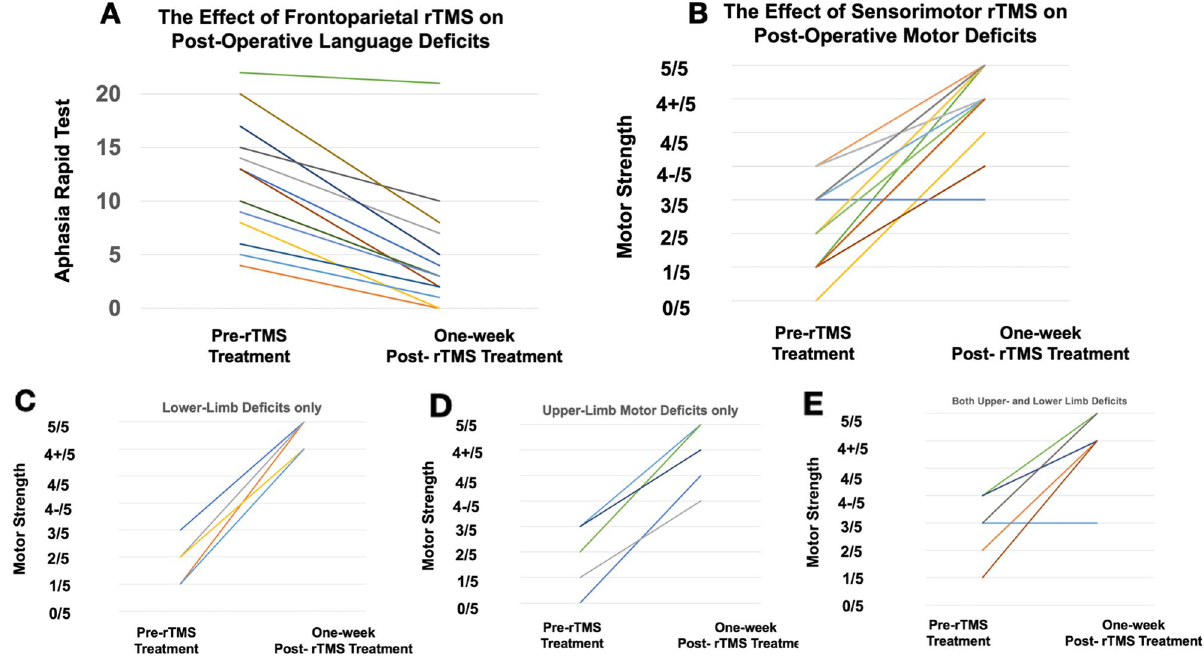
Figure 4. Neurological data (both language and motor) pre-rTMS treatment and 1-week post-rTMS treatment. ( A ) demonstrates a significant decrease in the ART 1-week following frontoparietal rTMS (p = 1.48 × 10 –3 . ( B ) demonstrates a significant increase in the MRC motor strength scale 1-week following sensorimotor rTMS (p = 8.0 × 10 –5 ). ( C – E) represents the data with patients with only lower-limb ( C ) or upper-limb ( D ), or both ( E ) limb